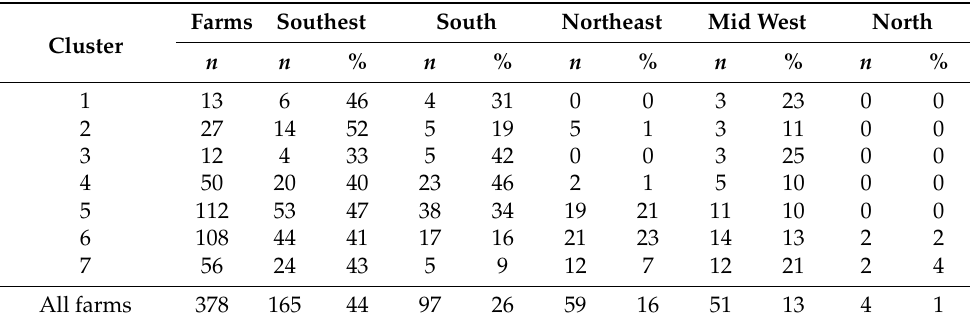
Table 2. Regional localization of farms clusters in Brazilian regions. Farms Southest South Northeast Mid West North Cluster n n % n % % n % %